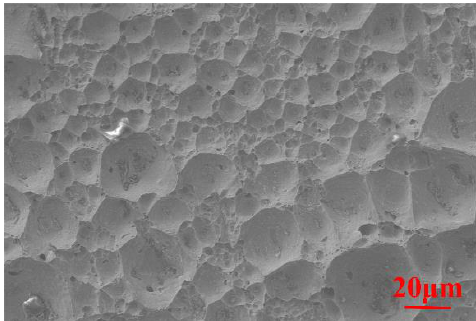
Figure 8. The contrast surface morphology of BGA under SEM at room temperature shows the ductile fracture.